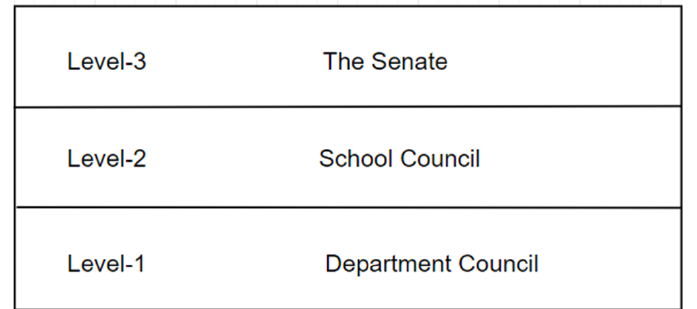
Figure 2. 3-Tier hierarchy.